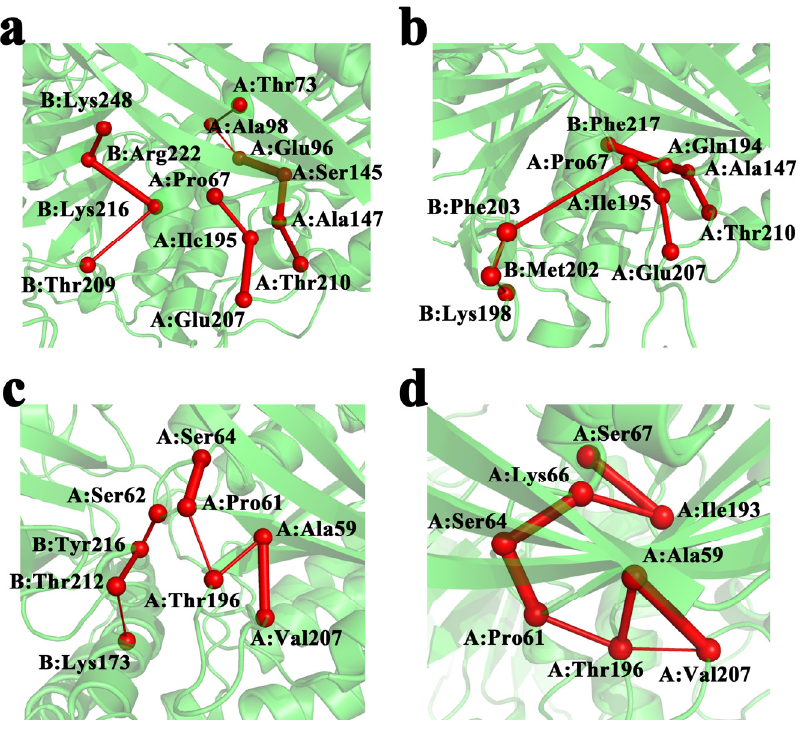
Figure 8. ATP-DNA communication pathway. ( a ) 298 K RecA; ( b ) 310 K RecA; ( c ) 298 K UvsX; ( d ) 310 K